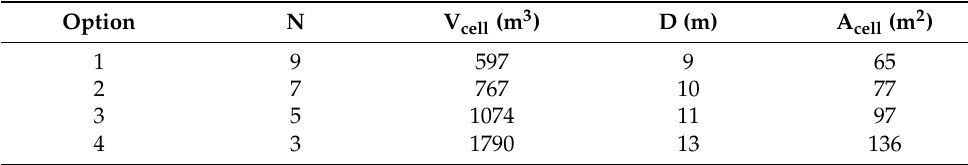
Table 1. Possible bank arrangement for conditions.